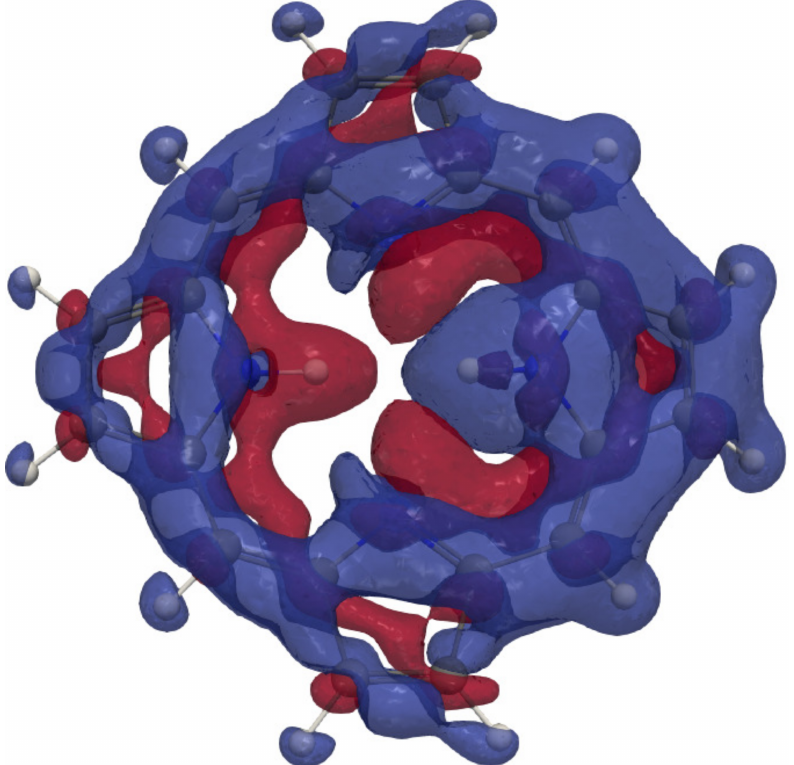
Figure 4. The isotropic 1 H NMR shielding density of the inner hydrogen of trans -porphyrin. The shielding contributions are shown in blue and the deshielding contributions in red. An isovalue of ± 0.04 has been